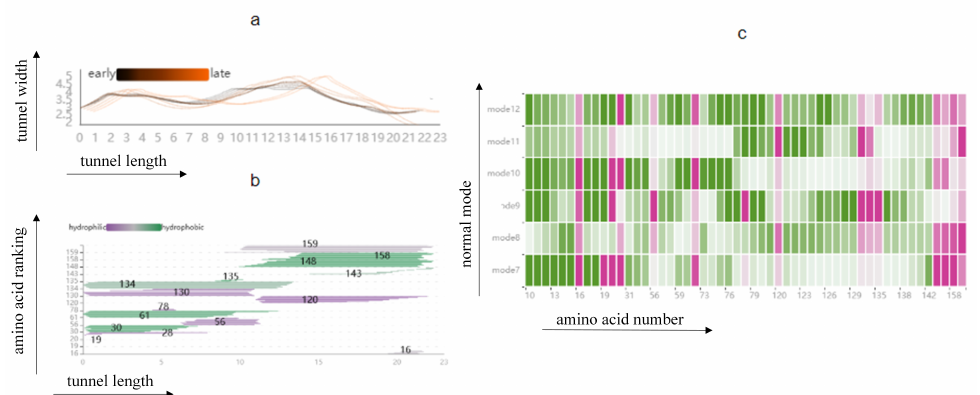
Figure 12. The graph shows information about the cavity and its surrounding amino acids: ( a ) Line graph showing the change in cavity radius and length with time; ( b ) histogram combined with line graph illustrating the distribution of amino acids around the cavity; ( c ) HeatMap showing the fluctuation of amino acids around the cavity.